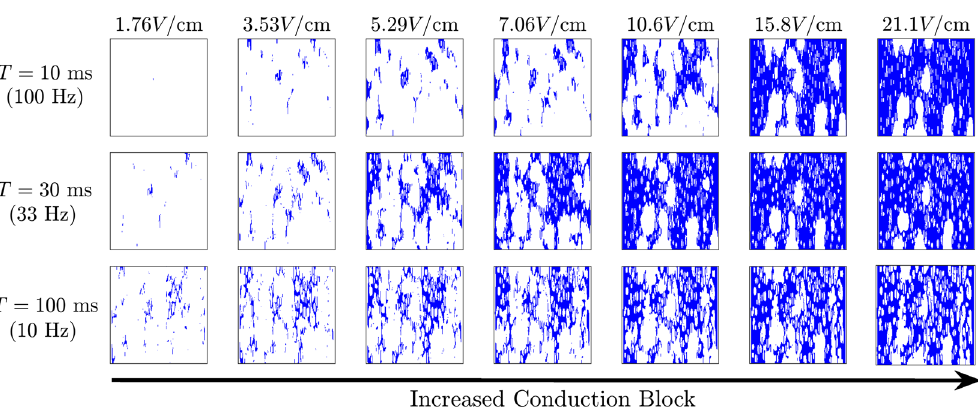
Figure 10. Under the application of a high-frequency external voltage field, locations that experience conduction block are shown in blue. For low amplitude stimulation, conduction block only occurs near large discontinuities in internal conductance. As the stimulation amplitude increases, conduction block becomes more prevalent partitioning the larger domain into disconnected subdomains that ultimately absorb spirals. In general, higher frequencies require a larger stimulation amplitude to elicit conduction block as predicted from the shape of α 1 ( T ) from Figure 5. For periods larger than about 80 ms, the asymptotic theory used to derive Equation (3) begins to break down. For each frequency shown here, electric fields with larger strength than those shown do not result in more conduction